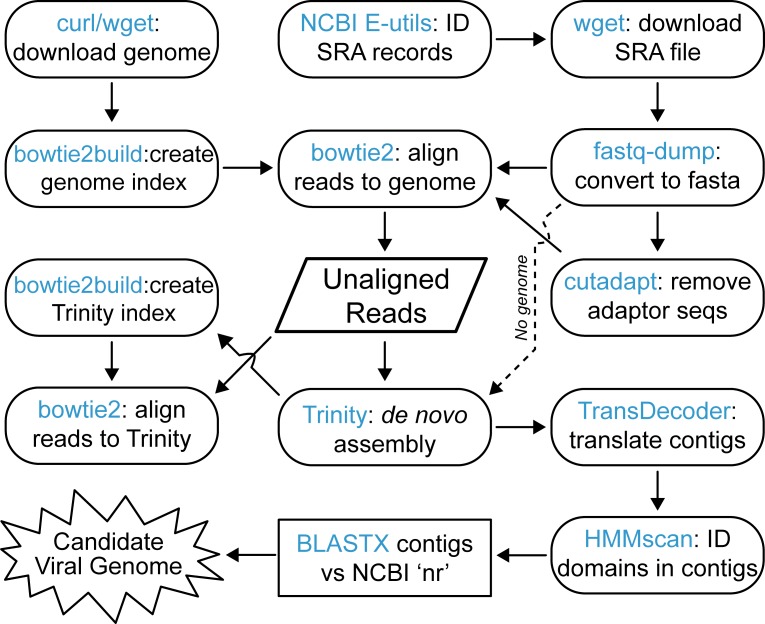
Bioinformatics steps of the virus-like RdRP discovery pipeline.Computational program names are highlighted in blue. Reads used in the bowtie2 alignment step were either as-is or adaptor-trimmed by cutadapt; details in the Materials and Methods. The dashed line indicates the workflow for fungi where no genome sequence was available; instead of running bowtie2, the reads were fed directly into a Trinity de novo assembly.